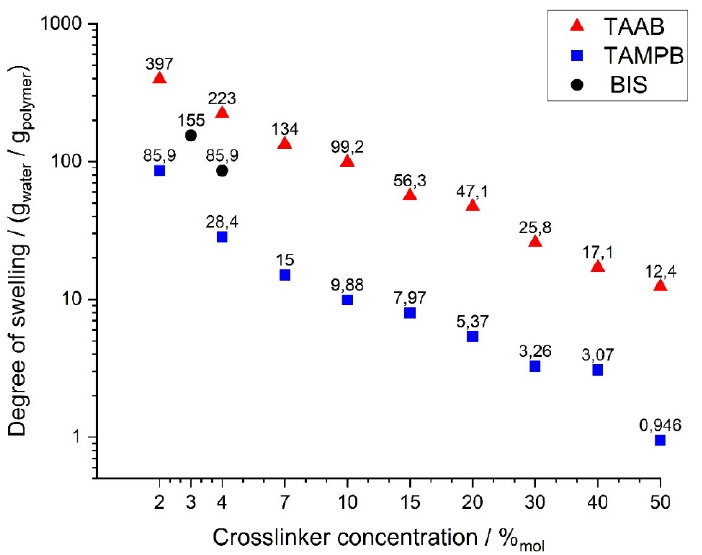
Figure 4. Swelling behaviour of poly(DADMAOH) gels with different crosslinkers as a function of the crosslinker concentration in bidistilled water. Reproducibility is approx. ± 10–14%. Due to the logarithmic scale, the error bars are smaller than the symbols and are therefore omitted.